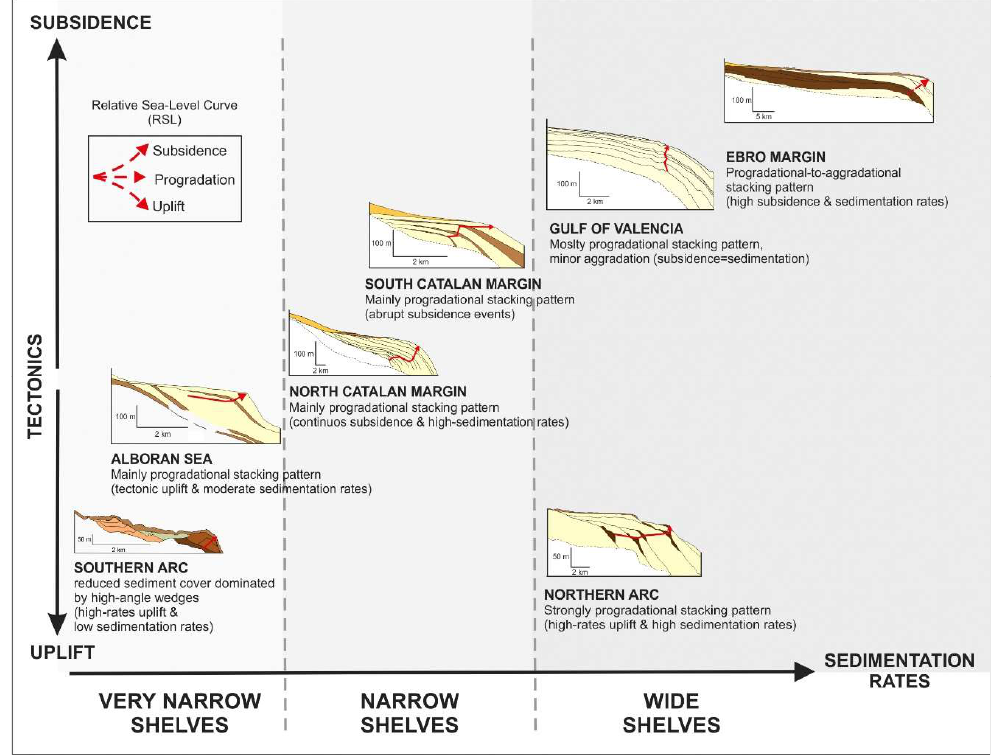
Figure 15. Summary of shelf stratigraphic architectures identified along the Iberian Mediterranean margin, under variable conditions of sediment supply and uplift-subsidence relationship. The northern and southern shelf sectors are narrower and steeper that the middle sector (Figure 4).